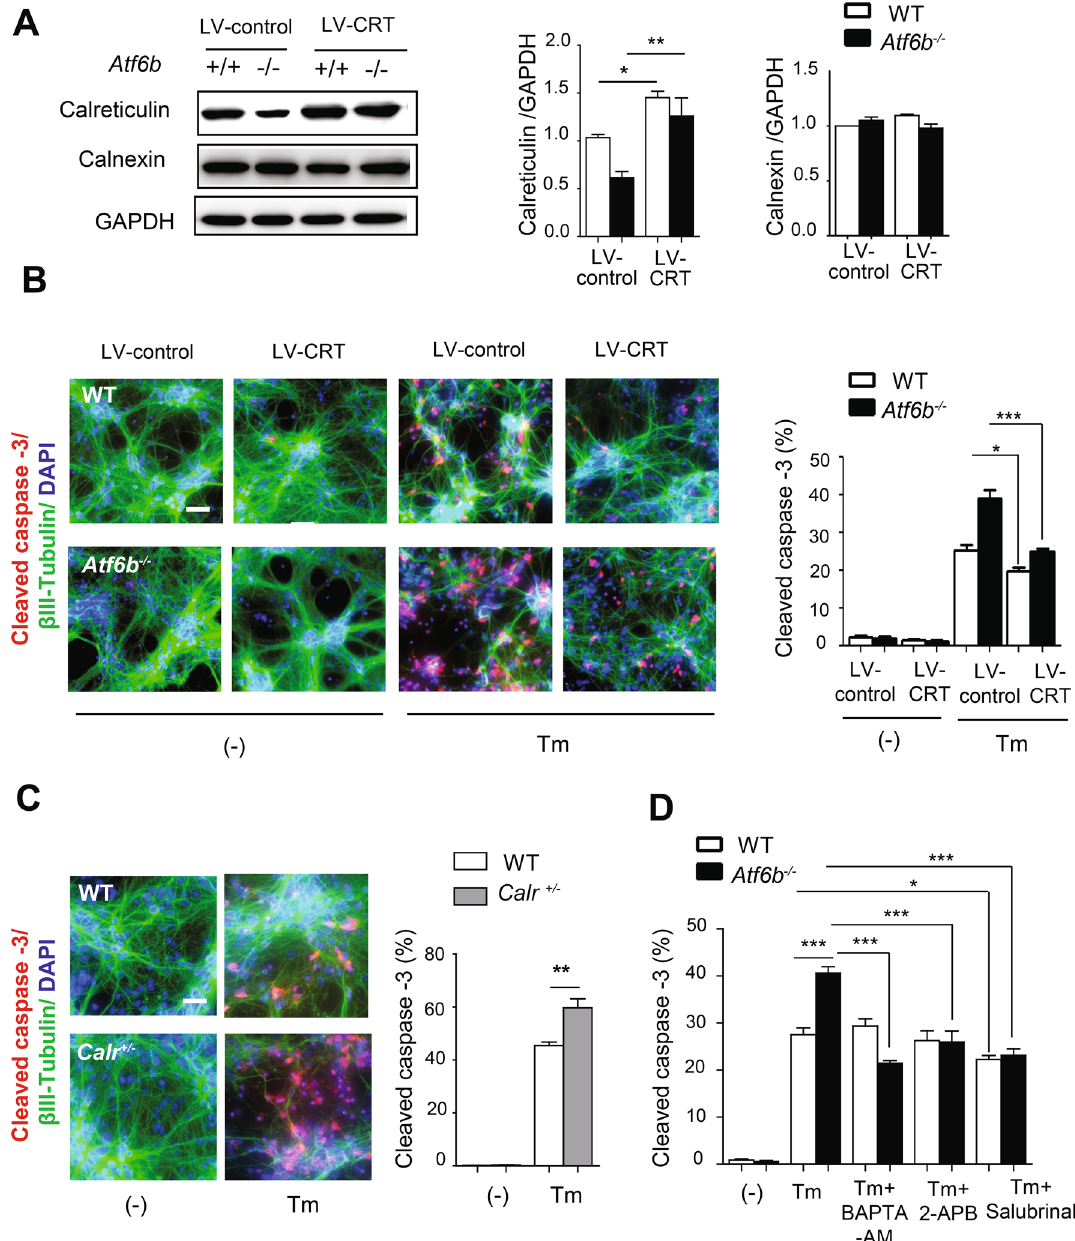
Figure 5. Protection of the primary hippocampal neurons by CRT or by treatment with Ca 2+ /ER stress- modulating compounds. ( A,B ) WT and Atf6b −/− hippocampal neurons were infected with a control or CRT- expressing lentiviral vector, and the expression levels of CRT and calnexin were measured by western blotting ( A ). n = 3 experiments. Data are shown as mean ± SEM. *p < 0.05, **p < 0.01 by a two-way ANOVA followed by the Bonferroni tests. Cells were then treated with Tm (1 μg/ml) for 24 h, and cell death was evaluated by immunocytochemical staining for cleaved caspase-3 ( B ). Scale bar: 20 μm. n = 3 experiments. Data are shown as mean ± SEM. *p < 0.05, ***p < 0.001 by a two-way ANOVA followed by the Bonferroni test. ( C ) WT and Calr + /− primary hippocampal neurons were treated with Tm (1 µg/ml) for 24 h, and cell death was evaluated by immunocytochemical staining for cleaved caspase-3. n = 3 experiments. Scale bar: 20 μm. Data are shown as mean ± SEM. **p < 0.01 by a two-way ANOVA followed by the Bonferroni tests. ( D ) WT and Atf6b −/− hippocampal neurons were treated with Tm (1 μg/ml) together with BAPTA-AM (5 µM), 2-APB (2 μM) or salubrinal (5 µM). Cell death was evaluated by immunocytochemical staining for cleaved caspase-3. n = 3 experiments. Typical images are shown in Fig. S5. Data are shown as mean ± SEM. *p < 0.05, **p < 0.01, ***p < 0.001 by a two-way ANOVA followed by the Bonferroni